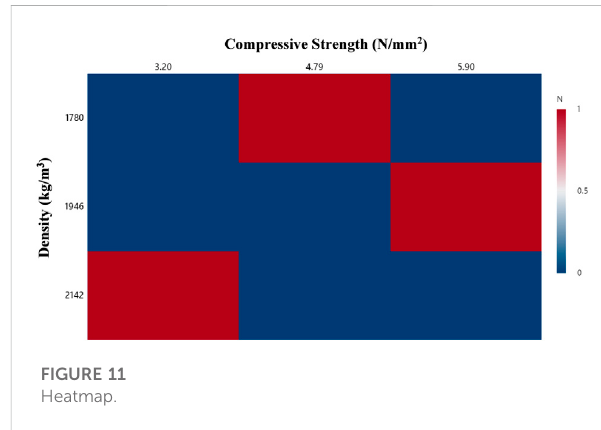
FIGURE 9 Main plot for density.